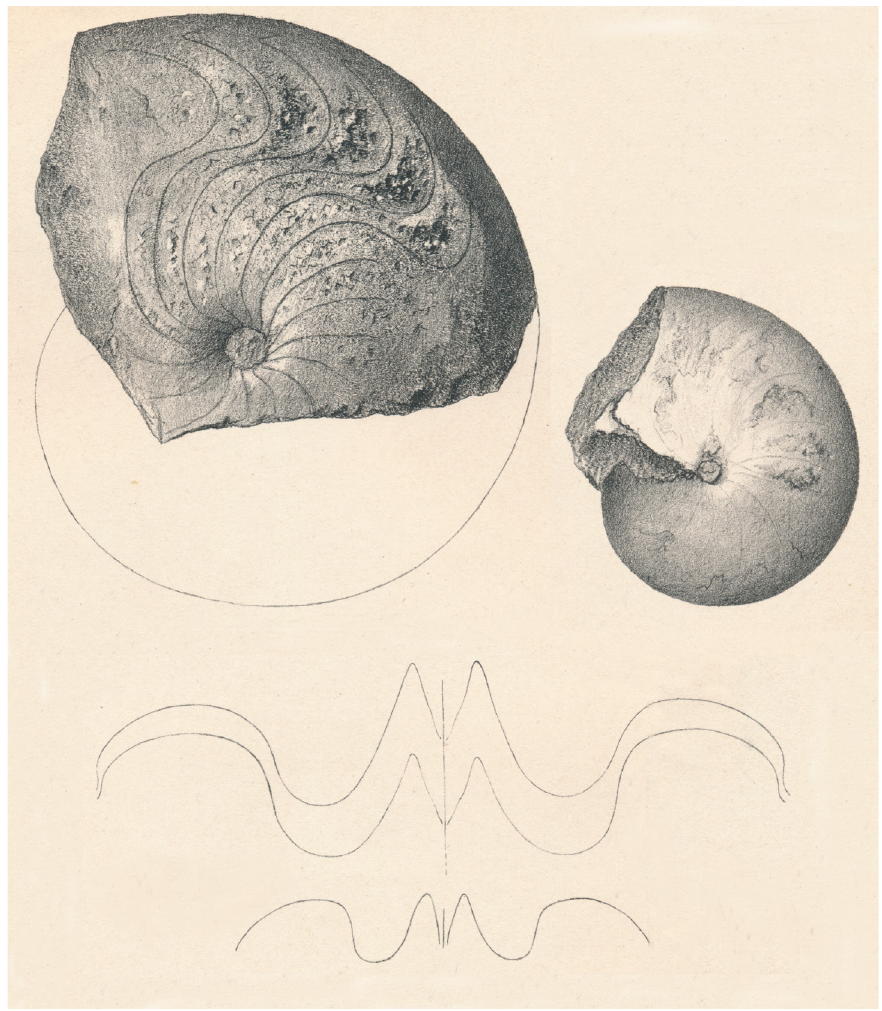
Fig. 6. Epitornoceras mithracoides (Frech, 1888), reproduction in original size of the illustration of the type material; paralectotype (MB.C.470) and lectotype (MB.C.469) by Frech